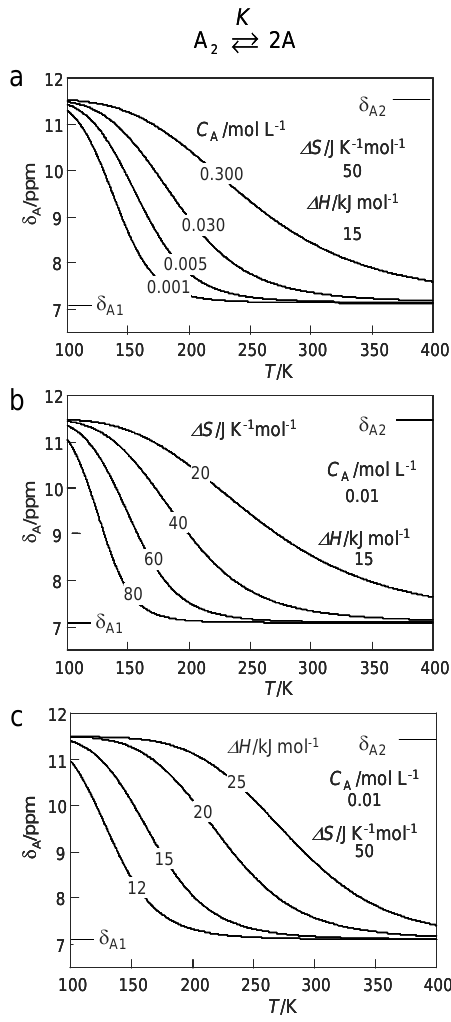
Figure 6. Model calculations according to Equations (4)–(8) of the influence of the dimer–monomer dissociation of a proton donor A on the average chemical shifts δ A of the mobile proton as a function of temperature. δ A1 and δ A2 are chemical shifts of the monomer and the dimer, respectively. Δ H and Δ S : reaction enthalpy and entropy of the dimer–monomer dissociation. C A : total concentration of the proton donor A. ( a ) Variation of C A , ( b ) variation of Δ S and ( c ) variation of Δ H . For further explanation see text.